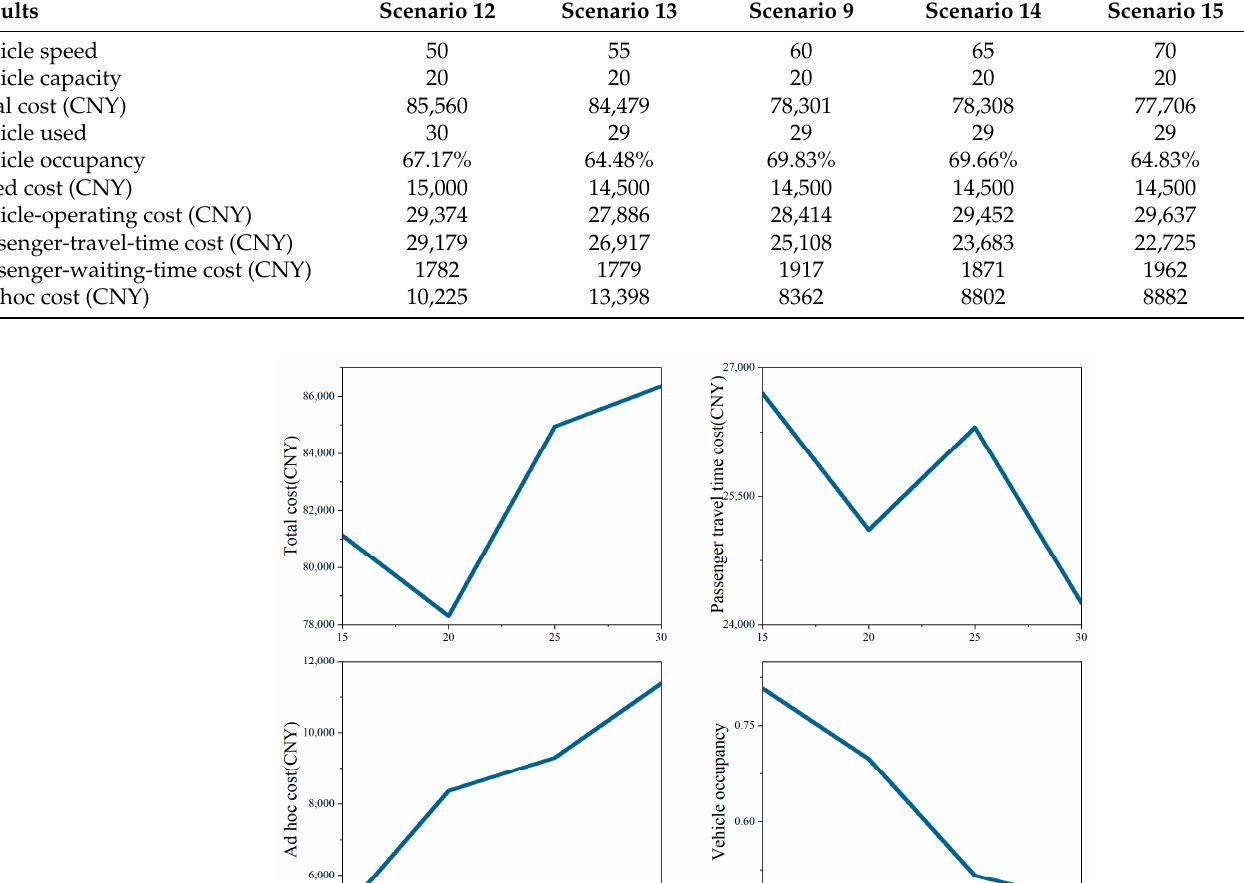
Figure 15. Sensitivity analysis of vehicle speed in Shenzhen airport. 7. Conclusions In this study, we developed a flexible-bus system with an ad-hoc service to meet er- ratic travel demand, and we solved it with accurate and hermetic methods. Additionally, we showed that the flexible-bus system outperformed the normal flexible-bus and taxi service in terms of overall travel costs and social welfare, using actual data from Shenzhen Airport. In order to obtain the most accurate travel demand from taxi-GPS data, we spe- cifically employed the ST-DBSCAN-clustering approach to screen out time-abnormal des- tinations and then choose the reserved bus stop. By explicitly including the ad-hoc service, the proposed model significantly reduces the overall cost, travel time, route length, and vehicle-vacancy rate, as compared to the practical flexible-bus system.